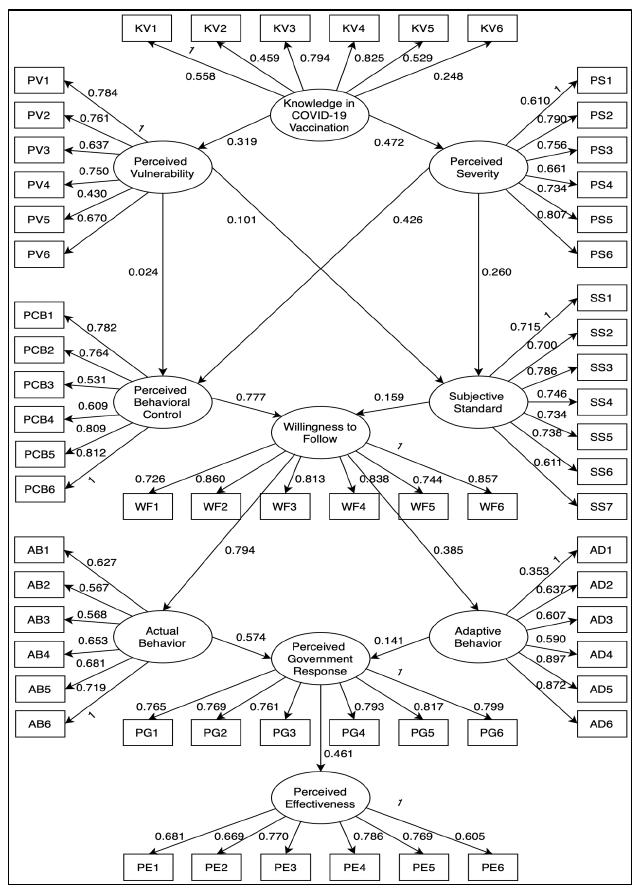
Figure 1. Initial SEM with indicators for evaluating factors affecting the perceived effectiveness of government response towards COVID-19 vaccination in Occidental Mindoro. A revised SEM was derived by removing the two latent variables that did not have a significant relationship from the initial SEM. Figure 2 shows the final SEM for the per- ceived effectiveness of government response towards COVID-19 vaccination in Occi- dental Mindoro. The proponents modified some indices to enhance the model fit based on previous studies that used the SEM approach [14].